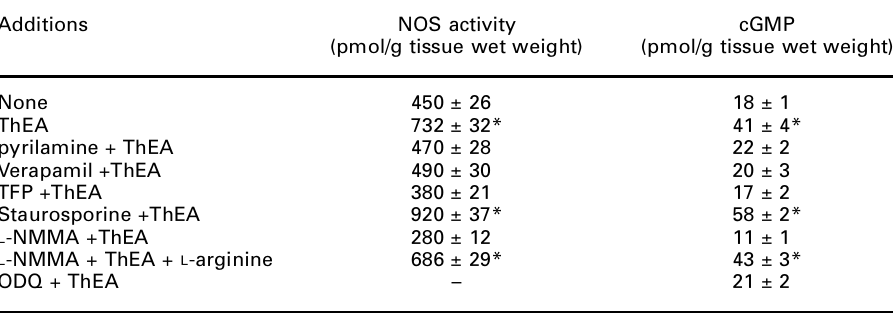
Table 2. Effect of ThEA upon NOS activity and cyclic GMP accumulation of rat submandibular gland slices: influences of different inhibitory agents Additions